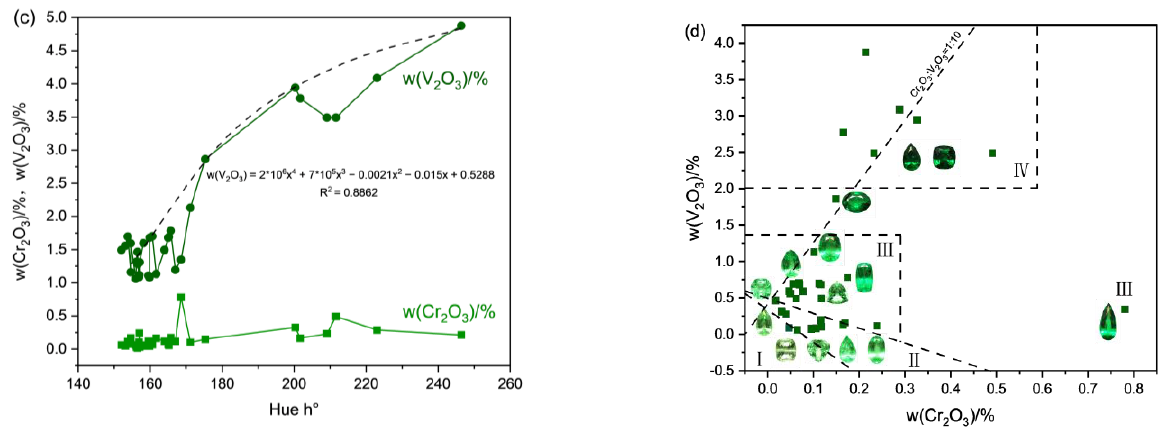
Figure 4. ( a ) Correlation between chroma C* and w(Cr 2 O 3 ) and w(V 2 O 3 ); ( b ) correlation between lightness L* and w(Cr 2 O 3 ) and w(V 2 O 3 ); ( c ) Correlation between hue h° and w(Cr 2 O 3 ) and w(V 2 O 3 ); ( d ) the content range of Cr and V elements of tsavorite in different colors, which is divided into four areas according to the visual effect: light green (I), mint green (II), intense green (III) and dark green (IV).